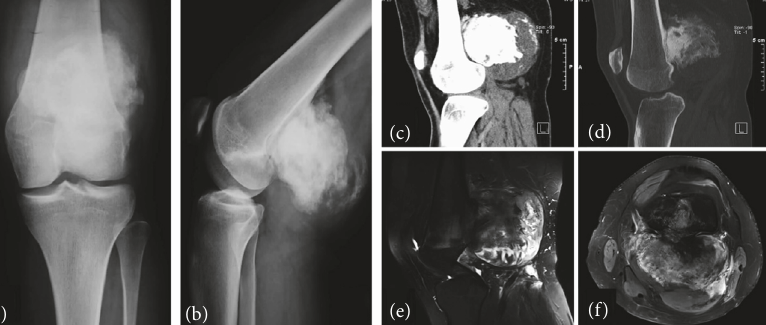
Figure 1: Parosteal osteosarcoma (PAO) in a 16-year-old female (no. 6). Anteroposterior (a) and lateral (b) radiographs of the knee showing a parosteal osteosarcoma as a large-ossified opacity attached to the posterior cortex of the distal femoral metaphysis. Sagittal computerized tomography (CT) reformatted images, soft tissue window (c), and bone window (d) demonstrate the characteristic separation between the tumor and the intact femoral cortex (cleft sign) as well as the ossified thick stuck lytic areas are seen within the ossified mass which is surrounded by a thick hypodense rim representing cartilaginous tissue. A fat-suppressed T2w magnetic resonance image sagittal (e) and axial view (f) showing the densely ossified stuck centrally, the inhomogenous moderately, T2 hyperintense mass in the middle, and the hyperintense cartilaginous component in the periphery. There is no intramedullary extension of the tumor.